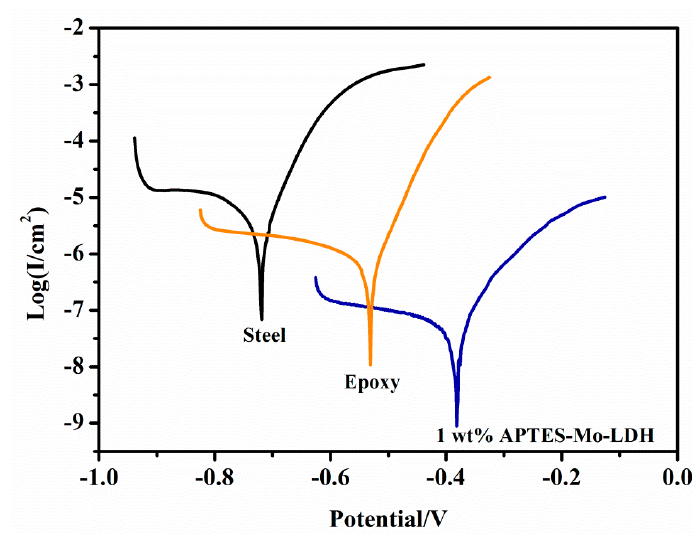
Figure 7. Tafel plot of bare steel, epoxy coating, and composite coating.